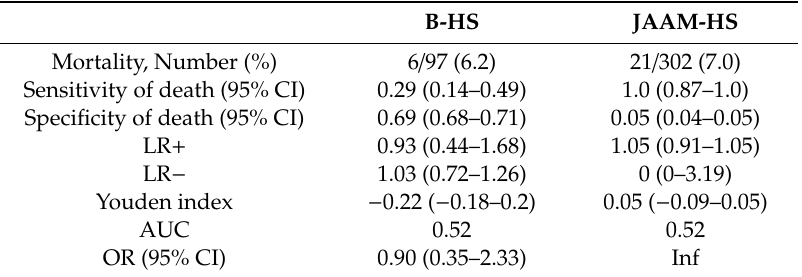
Table 4. Prediction of mortality among the B-HS and JAAM-HS